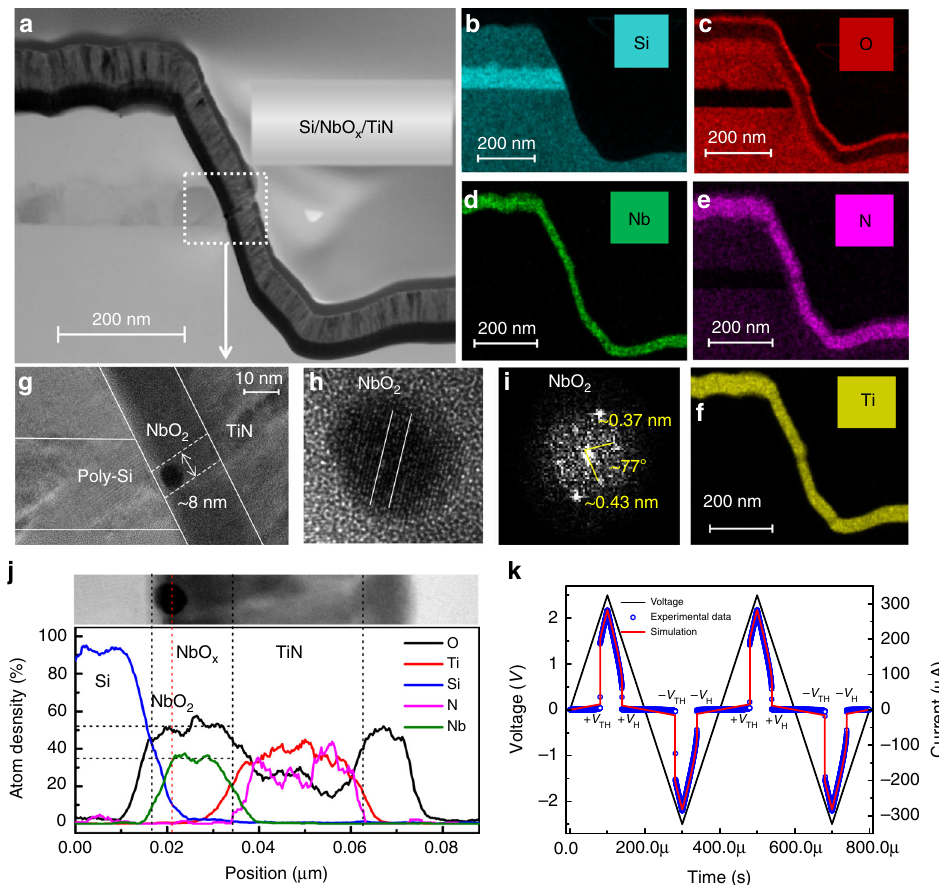
Fig. 2 NbO x device analysis. a Scanning electron micrograph cross-sectional image of the NbO x device. b – f The elemental mapping of the materials in the system for Si, O, Nb, N, and Ti, respectively. g , h Zoom-in views of the channel locations. i The diffraction pattern extracted by Fourier transform of h . j Energy dispersive spectra (EDS) of line scans of the channel. k Two switching cycles under triangular waves with 2.5 V/100 µ s ramp